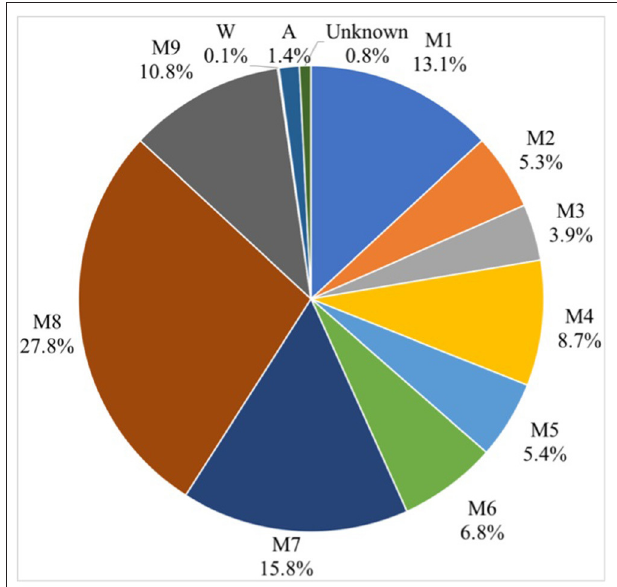
FIGURE 5 | Source Tracker results show the contribution of inferred sources of microbial contamination in dairy products. See Figure 1 for